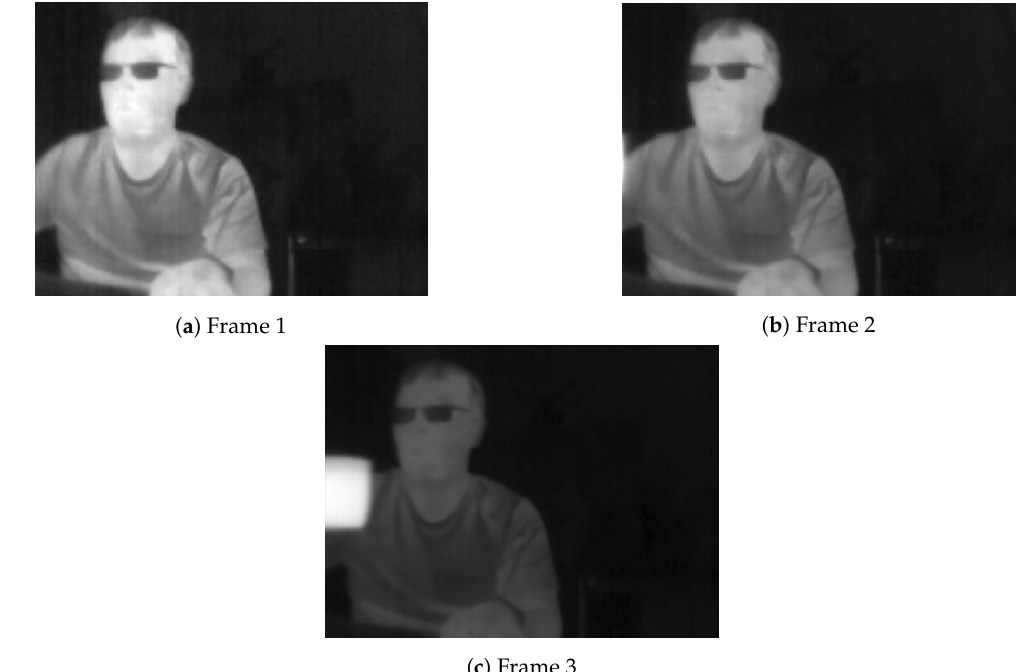
Figure 3. Change of contrast caused by AGC when a hot object moves into a